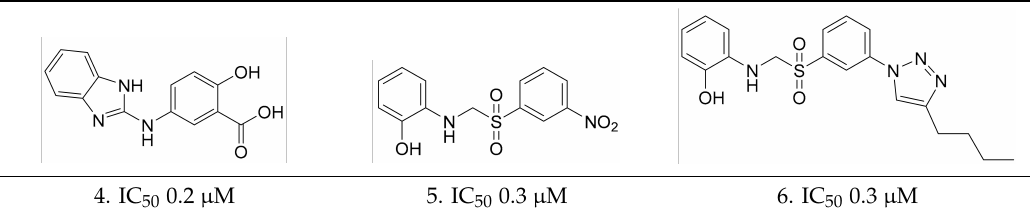
Table 2. Inhibitors of DDX3 helicase activity.